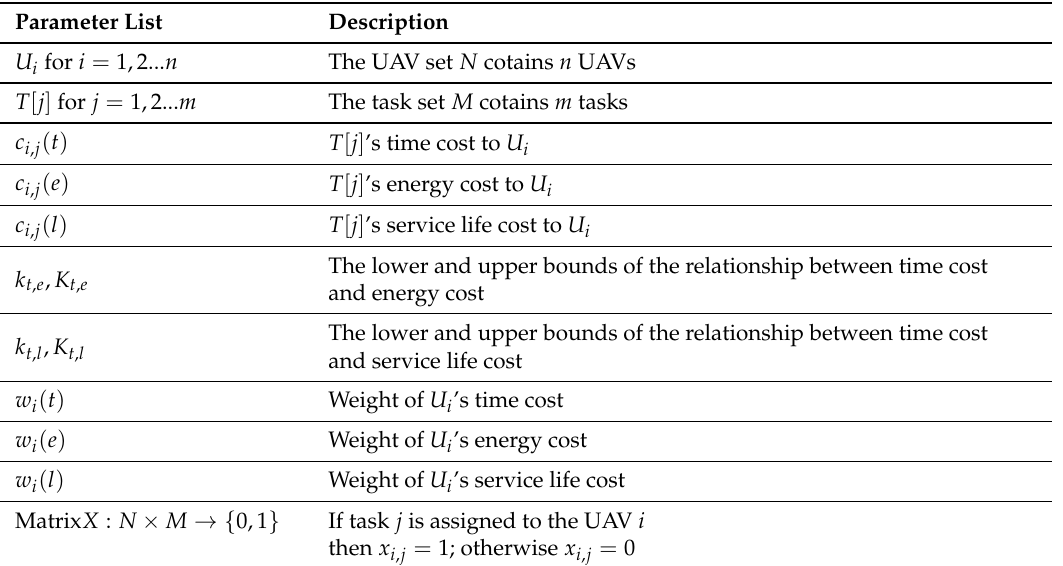
Table 2. Parameter settings.